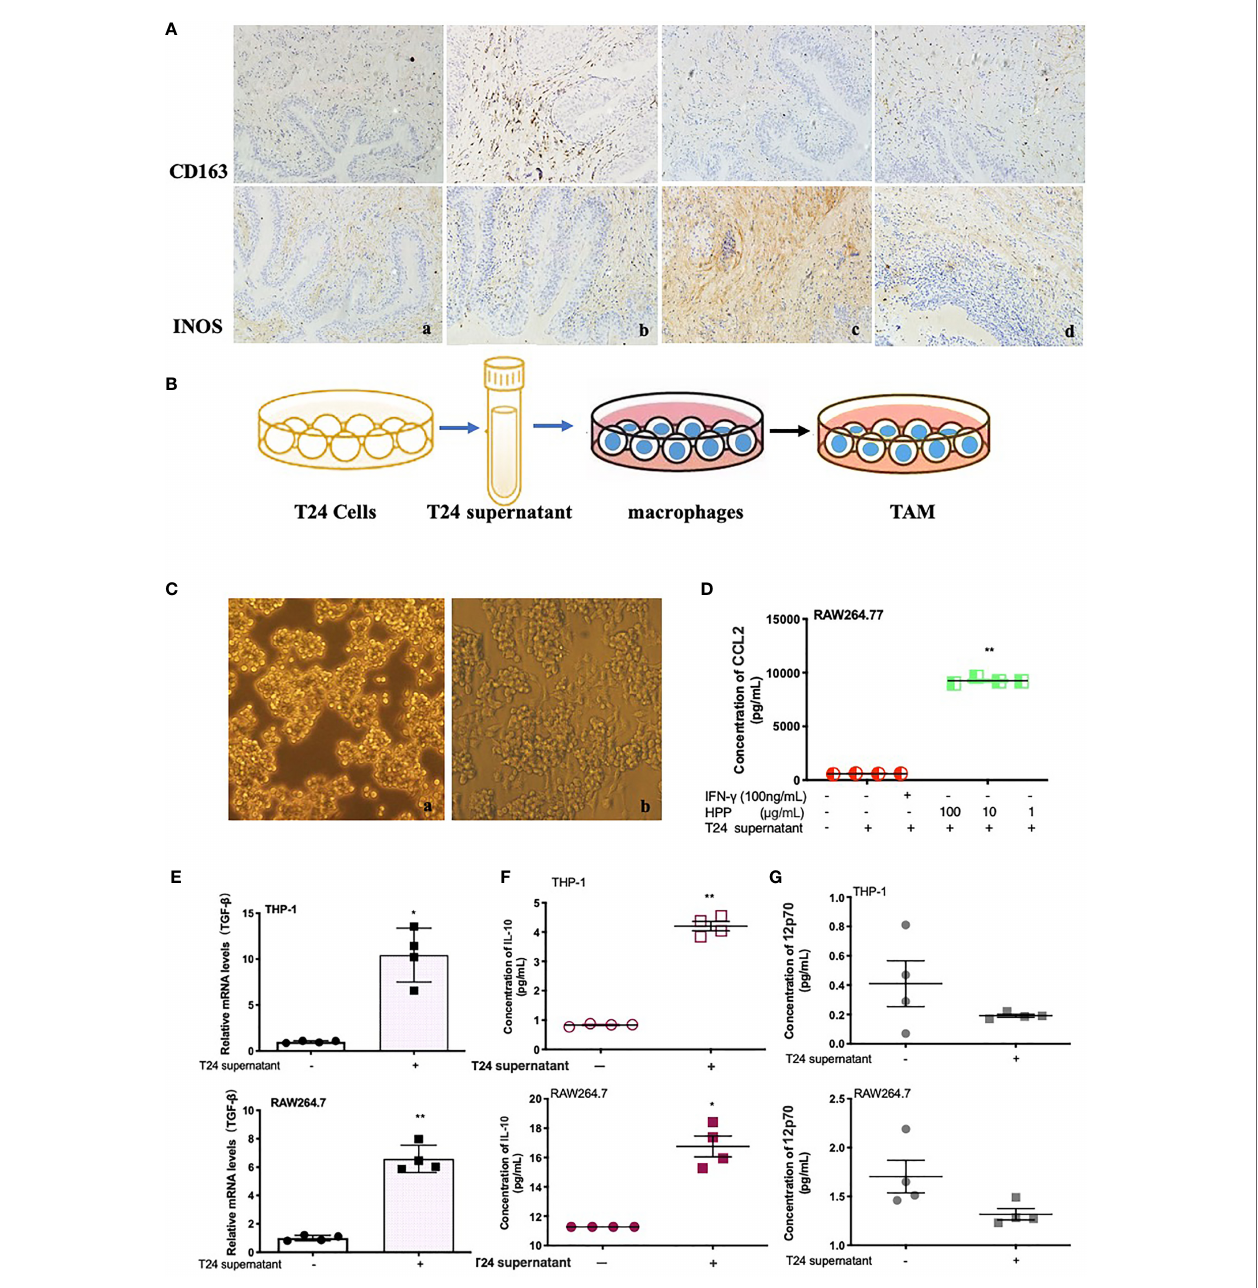
FIGURE 2 | Effect of polyporus on the tumor microenvironment and establishment of the TAM model in vitro . (A) Immunostaining of CD163 and iNOS. a. Control group, b. Model group, c. PPS group, d. WDP group. (B) Schematic diagram of macrophage co-culture with T24 supernatant. (C) Microscopy images of IFN- g - stimulated RAW 264.7 cells in medium or a co-culture microenvironment. a. RAW264.7 group, b. RAW264.7+T24 supernatant group. (D) CCL2 secretion in stimulated RAW 264.7 cells treated with T24 supernatant. (E) The expression of TGF- b mRNA in macrophages treated with T24 supernatant, followed by measuring the mRNA levels by qRT – PCR. (F, G) The secretion of IL-10 and 12p70 in macrophages treated with T24 supernatant. Values are given as the mean ± SD from three independent experiments. Compared with the control group, P < 0.05, ** P <